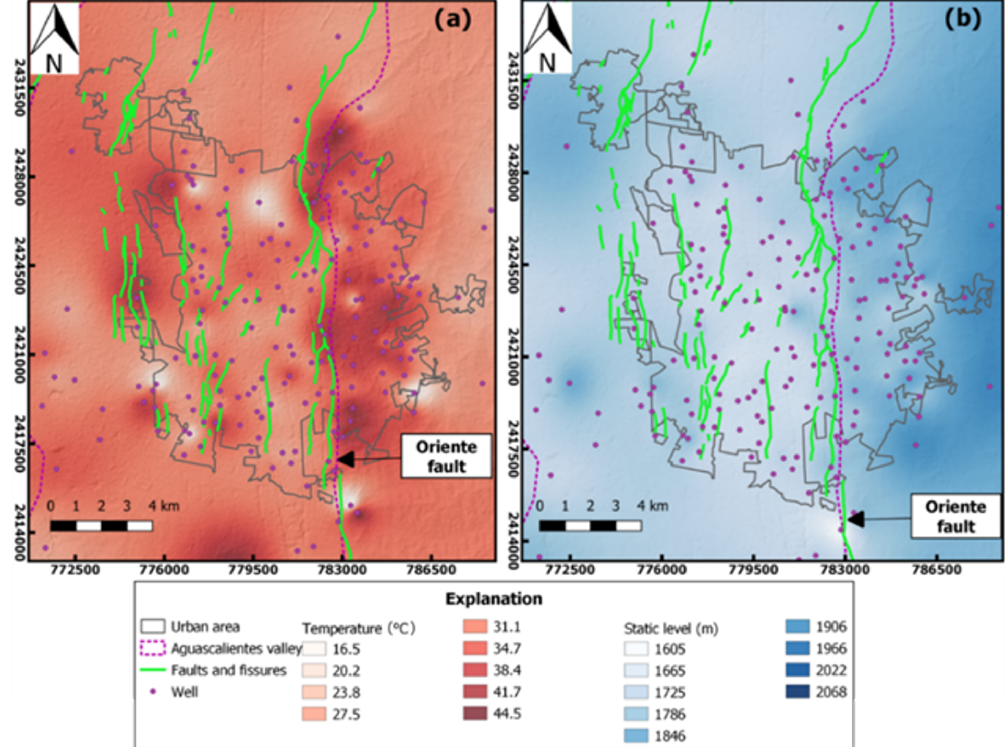
Figure 2. Variation of temperature (a) and groundwater levels (b) within the study area. Faults and fissures are included in the